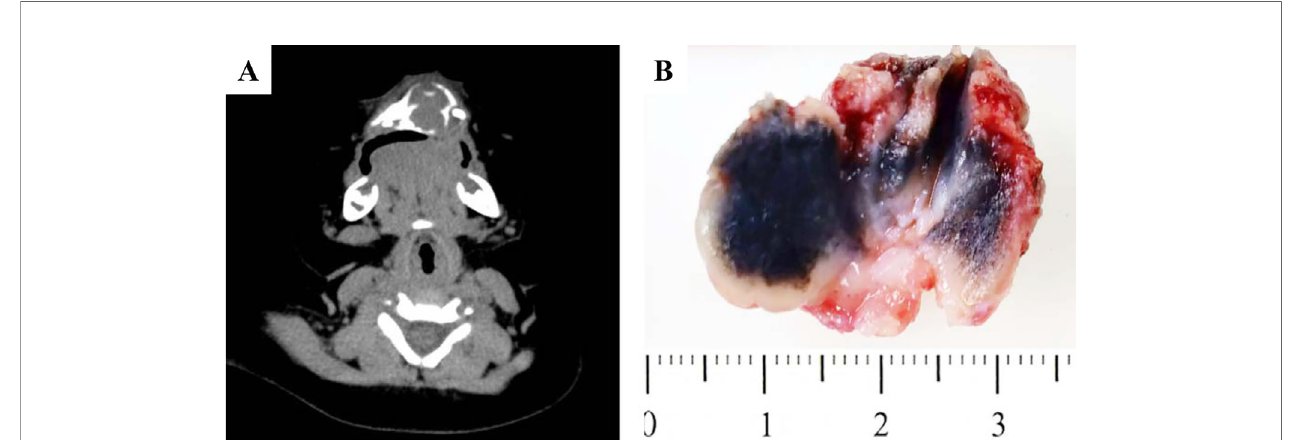
FIGURE 1 | Gross pictures and radiological features of MNTI. (A) CT images demonstrated well-de fi ned mass with lytic bone destruction and tooth germ affecting. (B) The tumor was fi rm, unencapsulated and the cut-surface was